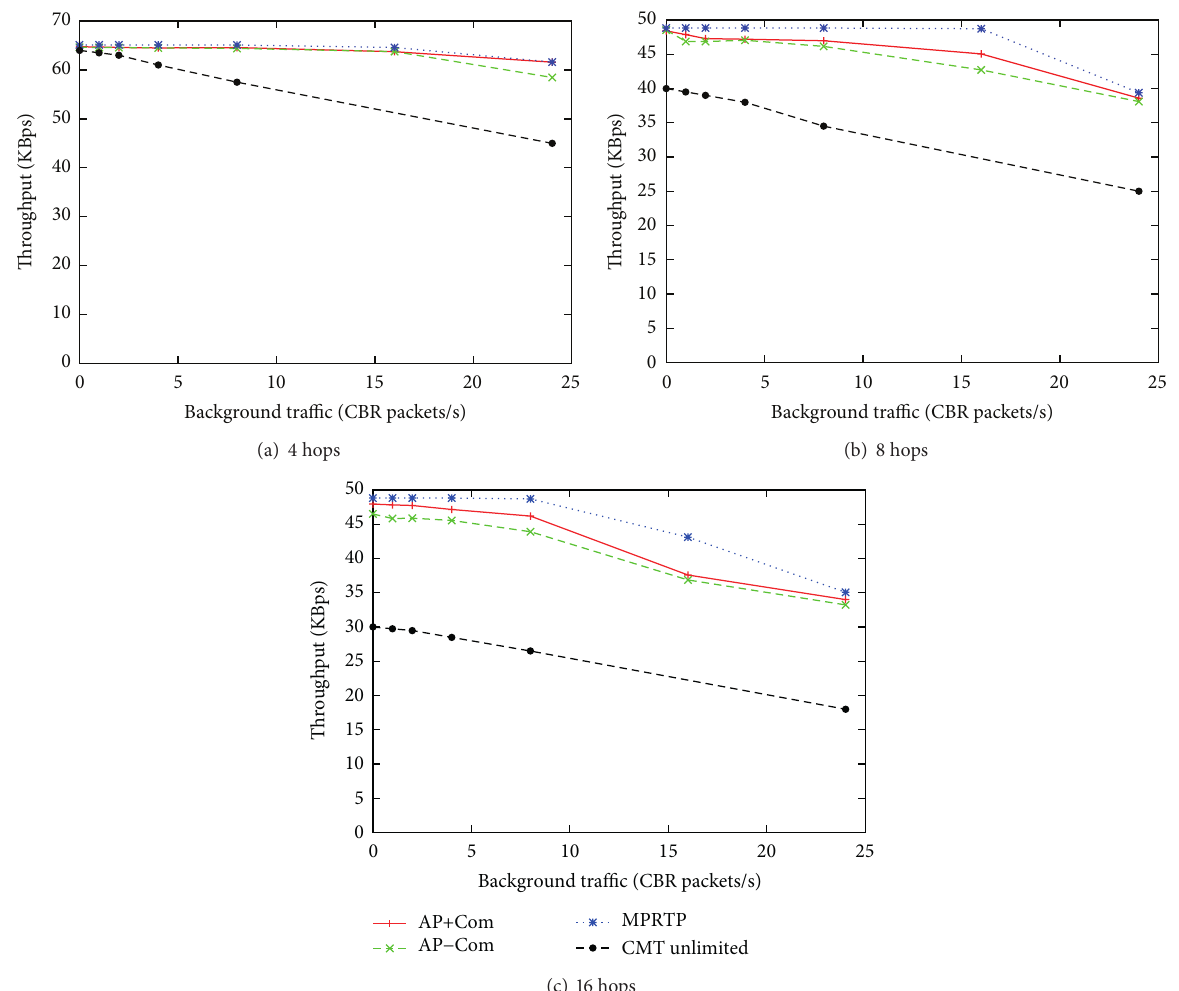
Figure 4: Throughput comparison between AP-based proposals, MPRTP, and CMT unlimited rBuf from